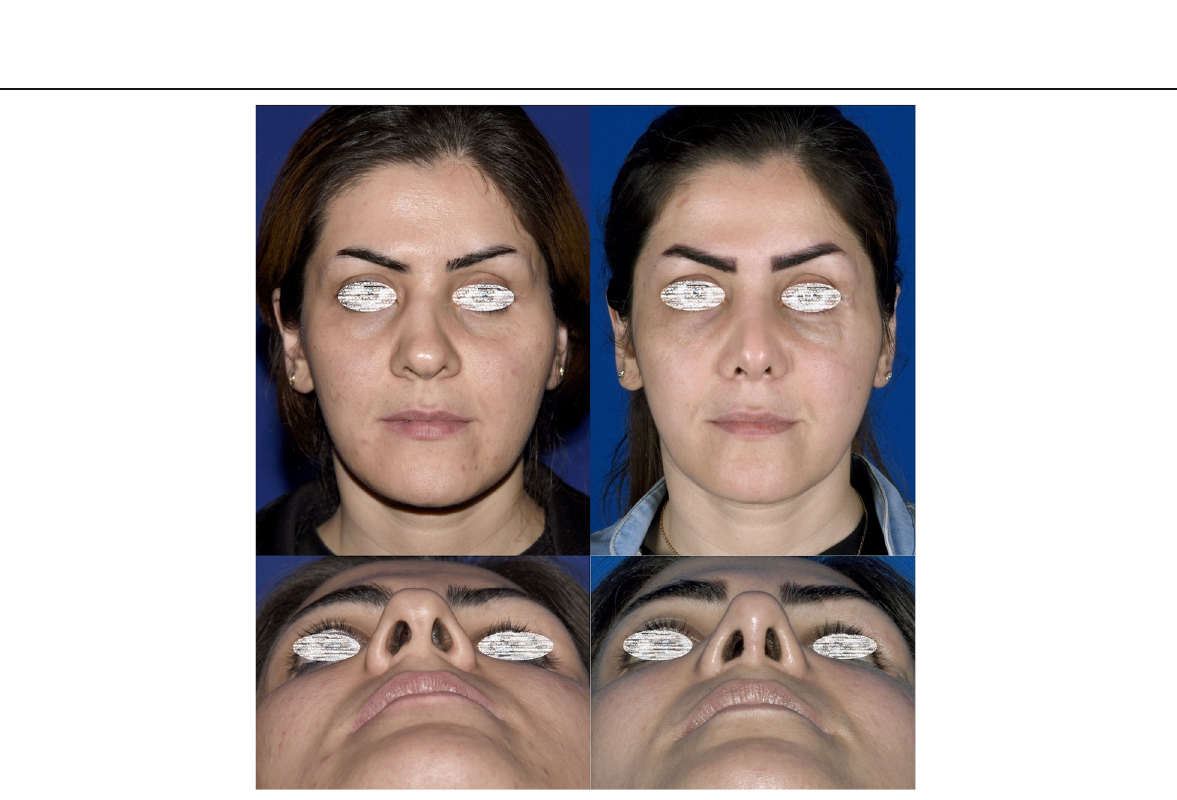
Fig. 5 Patient with congenial asymmetry of the nasal sill area who underwent sill graft with alar base approach. The figure shows preoperative and postoperative views from frontal aspect ( a , b ) and basal aspect ( c , d ). b , d Postoperative views